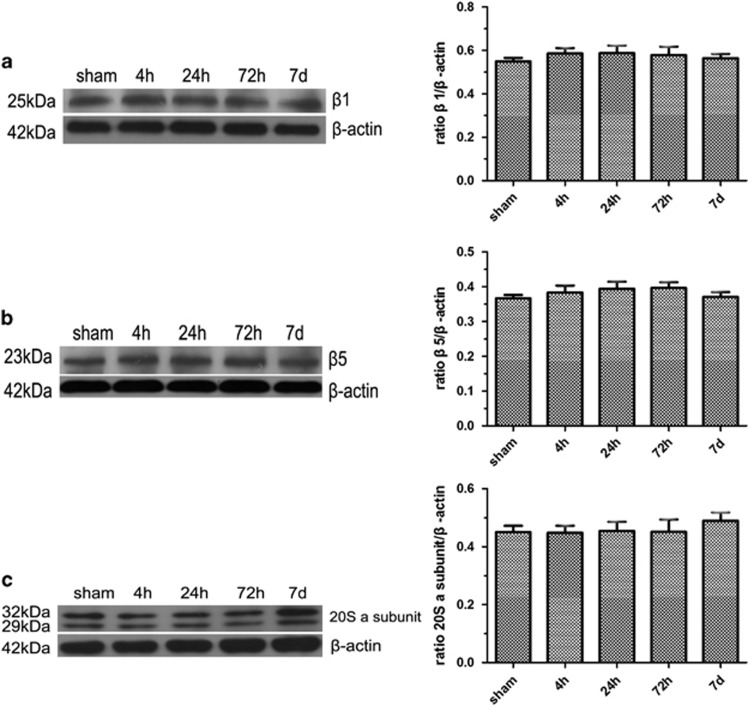
Expression of β1, β5 and 20S α subunits in the brains of MCAO rats. Western blot confirmed that protein levels of β1, β5 and 20S α subunits (1,2,3,5,6,7) did not show a significant change from 4 h to 7 days in the cortex and striatum under ischemia condition, respectively (P>0.10, compared with the sham-operated group; P>0.10 compared with the previous time point) (a–c). Five rats in each group were used for western blot (n=5), sham, sham-operated control rats